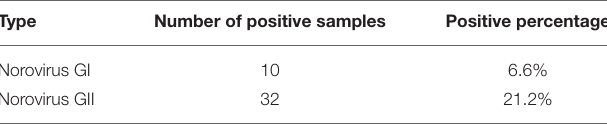
TABLE 2 | Detection of NoV in oyster samples.